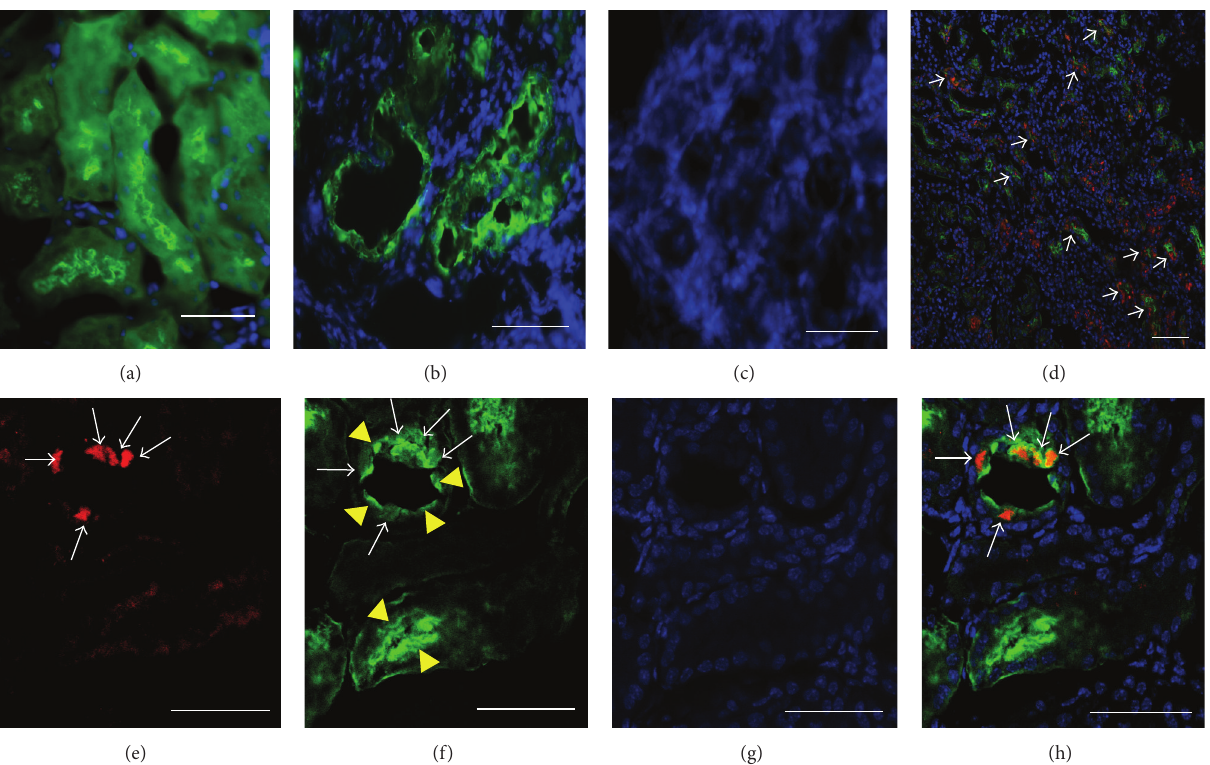
Figure 6: Exogenous renal embryonic CD 24+ cells stained with PKH26 red integrate into the renal tubules of adult mice with glycerol-induced proximal tubular injury. (a) Lotus tetragonolobus agglutinin (LTA) staining of normal control renal proximal tubules (green). (b) LTA staining of kidney (green) 3 days after induction of acute tubular injury with 50% glycerol 8 𝜇 L/g shows tubular dilatation, flattening, and detachment of proximal tubular cells. (c) No uptake of red dye is seen in glycerol-injured kidneys following infusion of the supernatant from the PKH26 red staining procedure for CD 24+ cells. (d) Following infusion of PKH26 red-stained CD 24+ cells into glycerol-injured mice, exogenous cells are seen within the damaged renal tubules (white arrows). (e–h) Confocal immunofluorescent microscopy examining integration of CD 24+ cells into the wall of glycerol-damaged proximal tubules. (e) Patchy integration of PKH26 red CD 24+ cells into the proximal tubular wall (white arrows). (f) Exogenous CD 24+ cells (white arrows) have a polarized appearance and stain for LTA (green) and are intercalated among the endogenous LTA(+) epithelia (yellow arrow heads). (g) The same section stained with DAPI alone. (h) Merged image of (e), (f), (g). Scale bars: 50 𝜇 m (f) and 70 𝜇 m (g–j). LTA: green; DAPI: blue; PKH26: